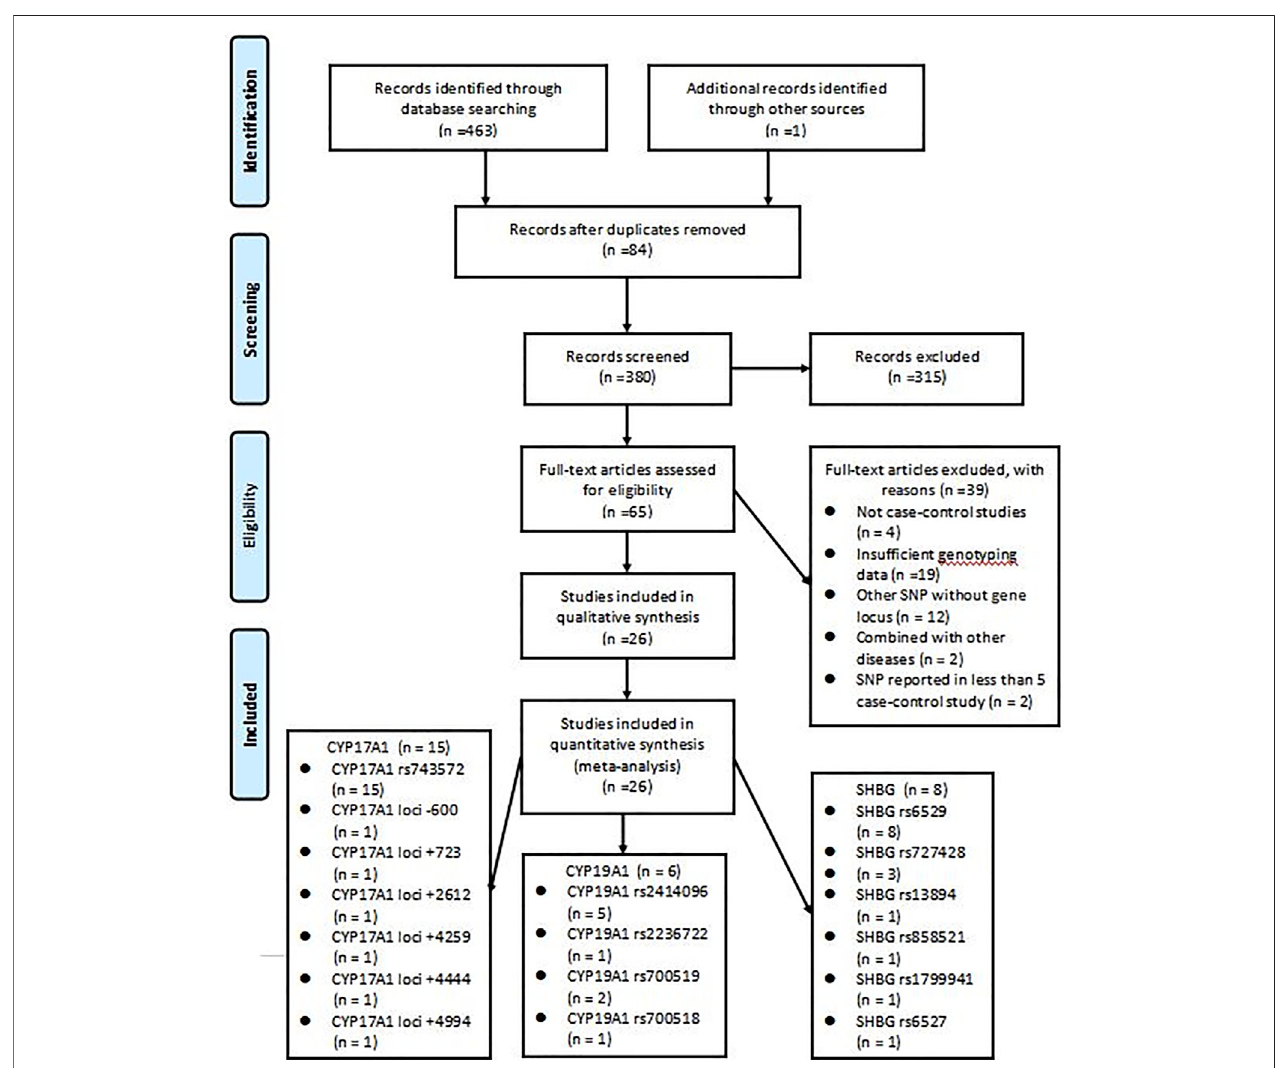
FIGURE 1 | Flow diagram of studies identi fi ed in the systematic